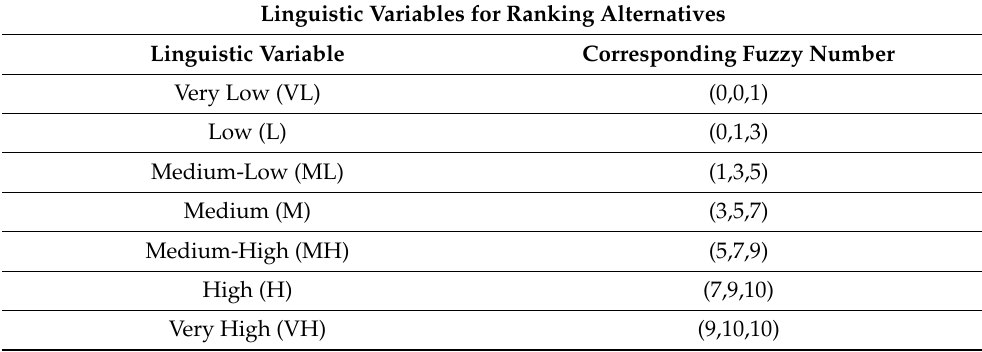
Table 1. Linguistic variables and corresponding fuzzy triangular numbers. Linguistic Variables for Ranking